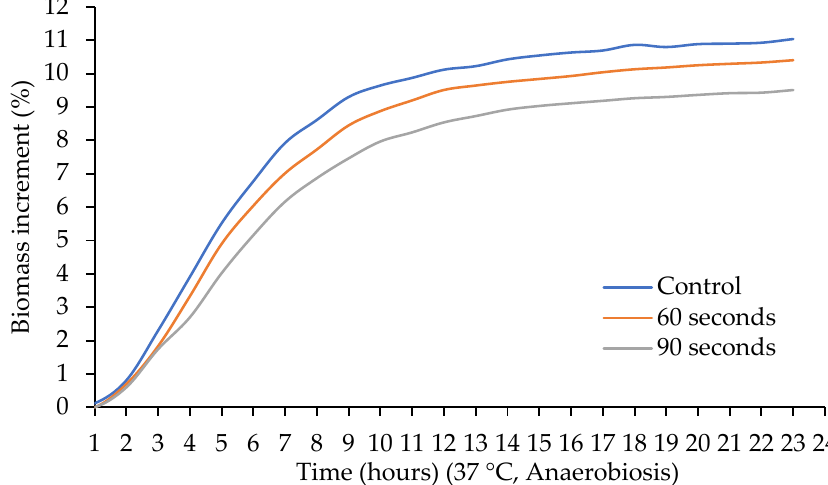
Figure 4. Effect of sonication time on the biomass increment of Lactobacillus acidophilus .